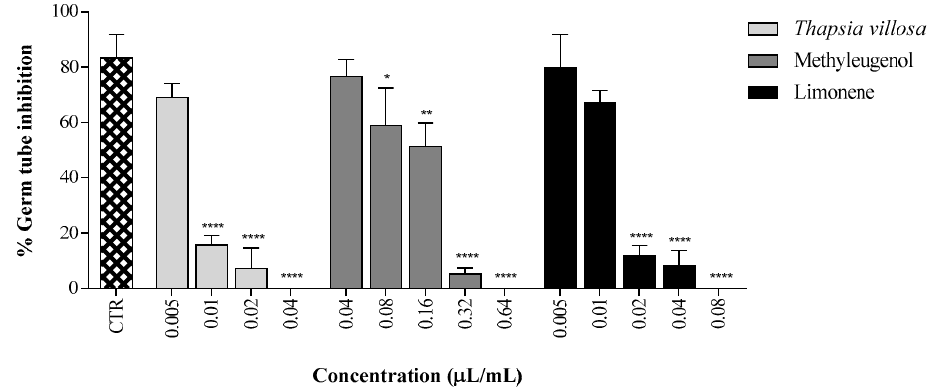
Figure 1. Percentage of germ tube formation by Candida albicans ATCC 10231 incubated with Thapsia villosa essential oil and its main components methyleugenol and limonene. Results are expressed as mean ± SD of three independent experiments. Statistical differences at * p < 0.05, ** p < 0.01 and **** p < 0.0001 (ANOVA, Tukey HSD multiple comparison test), face to the control.